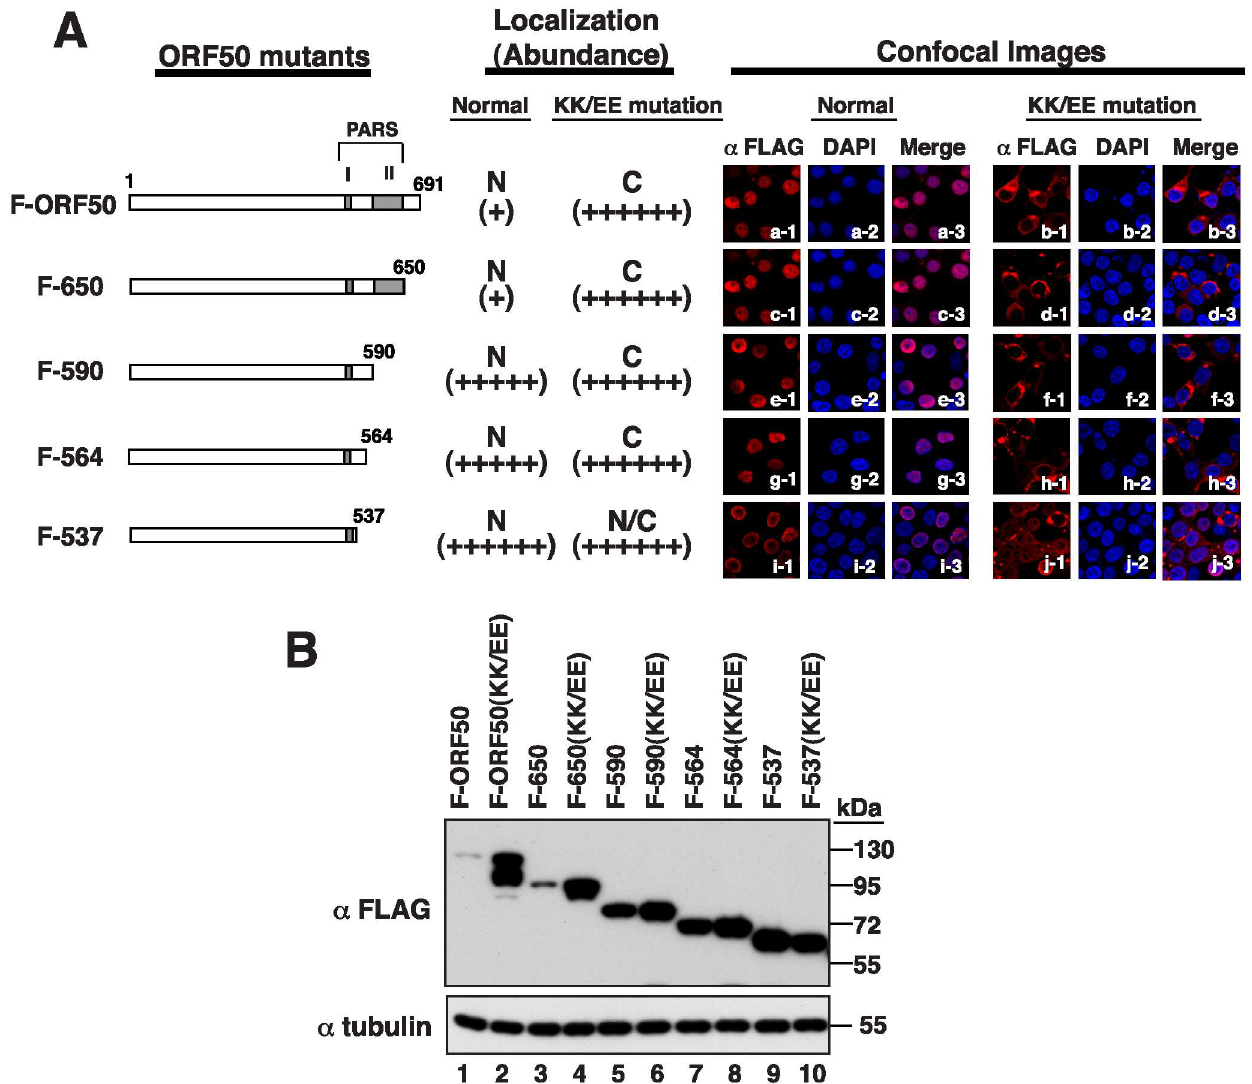
Fig 4. The PARS-II motif functions in the nucleus in the control of ORF50 abundance. (A) Left, diagram of PARS-I and/or PARS-II mutants of ORF50. A series of ORF50 C-terminal deletionswith or without the KK-to-EE mutation in the PARS-I motif were included.All ORF50 mutants contain a FLAG tag at their N terminus. The subcellular localization and protein abundanceof each of ORF50 mutants in 293T cells are summarized in the diagram. The degree of protein abundanceis indicatedby “+”. N: nucleus; C: cytoplasm; N/C: both nucleus and cytoplasm. Right, representative confocal images showingthe subcellular localizationof these ORF50 mutants. (B) Immunoblot analysis of ORF50 deletionmutants in 293T